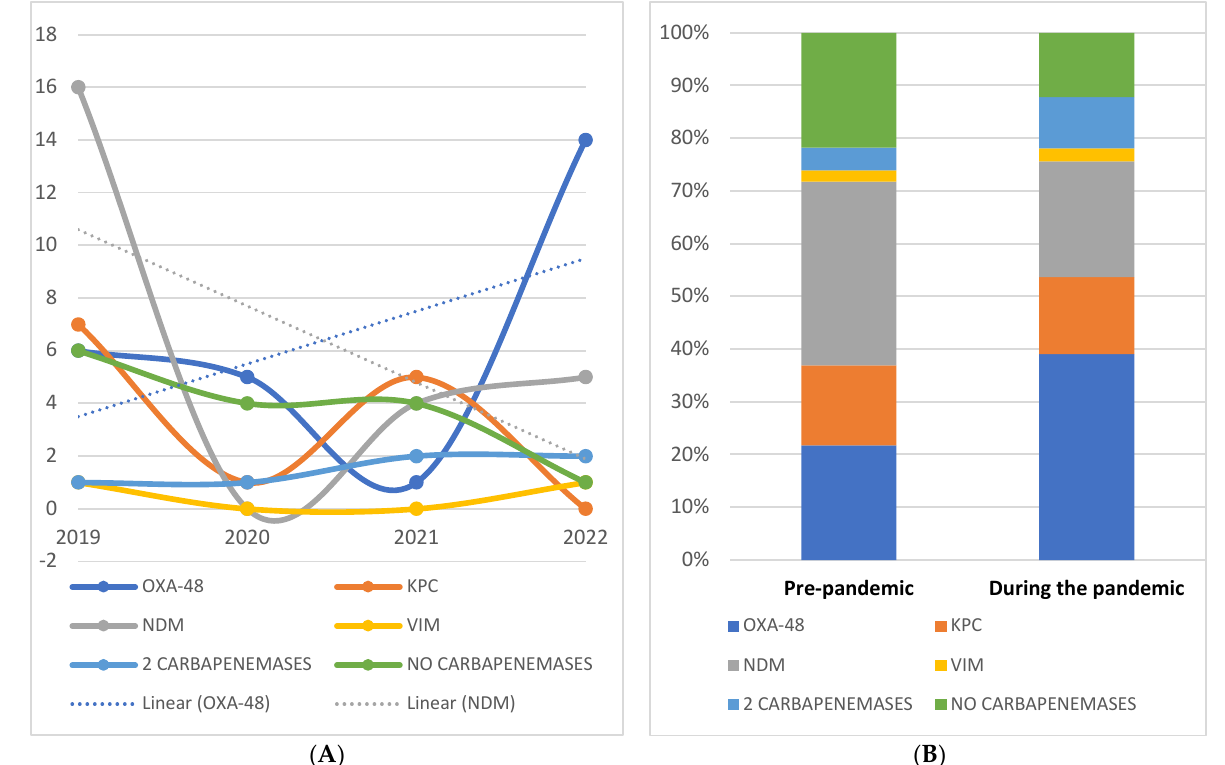
Figure 2. ( A )—Chronological distribution of carbapenem-resistant isolates during 2019−2022. ( B )—Types of carbapenemases production before and after the onset of the COVID−19 pandemic.